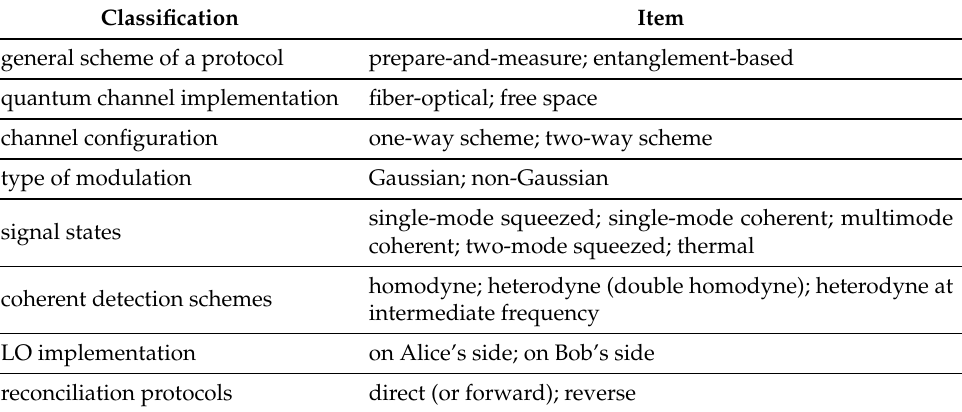
Table 1. Possible classifications of CV-QKD protocols.